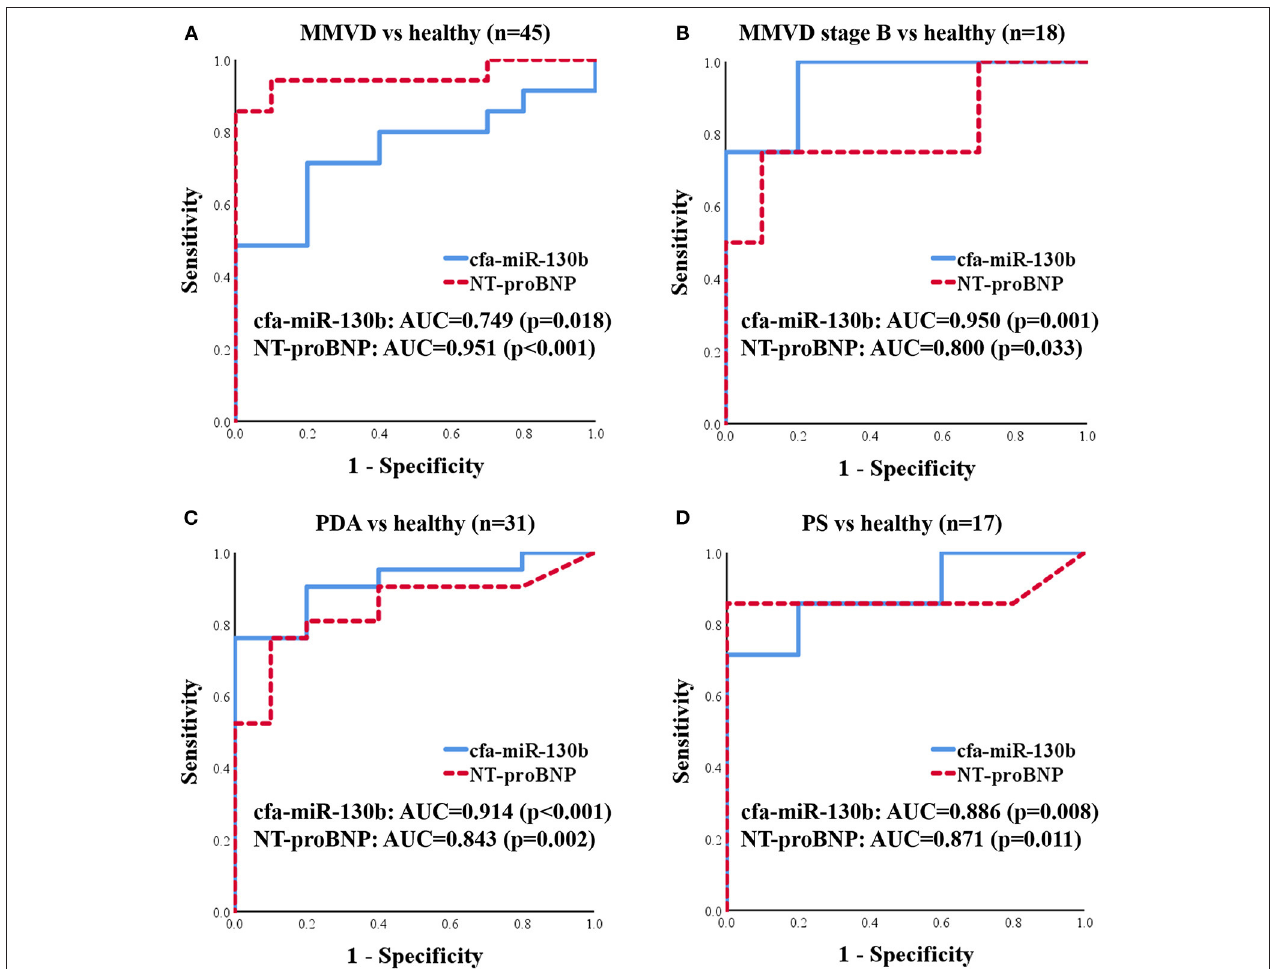
FIGURE 5 | ROC curves for cfa-miR-130b and NT-proBNP to discriminate dogs with MMVD ( n = 35) (A) , MMVD stage B ( n = 8) (B) , PDA ( n = 21) (C) , and PS ( n = 7) (D) from healthy dogs ( n = 10). AUC, area under curve; MMVD, myxomatous mitral valve degeneration; NT-proBNP, N-terminal pro B-type natriuretic peptide; PDA, patent ductus arteriosus; PS, pulmonic